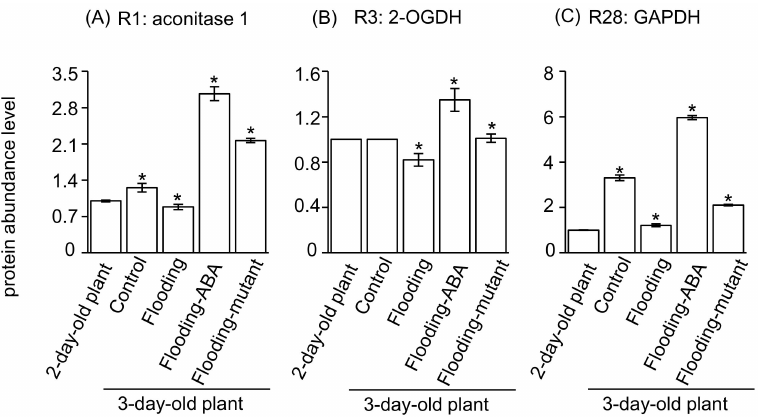
Figure 6. Protein abundance of aconitase 1,2-oxoglutarate dehydrogenase, and glyceraldehyde-3-phosphate dehydrogenase in soybean at an early stage of flooding. ( A ) Protein abundance of aconitase 1 (R1) in soybean at an early stage of flooding; ( B ) Protein abundance of 2-oxoglutarate dehydrogenase (R3) in soybean at an early stage of flooding; ( C ) Protein abundance of glyceraldehyde-3-phosphate dehydrogenase (R28) in soybean at an early stage of flooding. Two-day-old wild-type soybean plants were treated without or with flooding for one day. For ABA treatment, 10 µ M ABA was supplied to wild-type soybeans exposed to flooding at the same time. Two-day-old flood-tolerant mutant plants were exposed to flooding for one day. Unstressed wild-type soybean plants served as controls. Root samples (including the hypocotyl) were collected for protein extraction. SIEVE analysis was performed to examine protein abundance. Data shown are means ± SD from three independent biological replications. Two-day-old unstressed wild-type soybean plants were used for comparison. * p < 0.05 (Student’s t -test). Abbreviations are as follows: 2-OGDH,